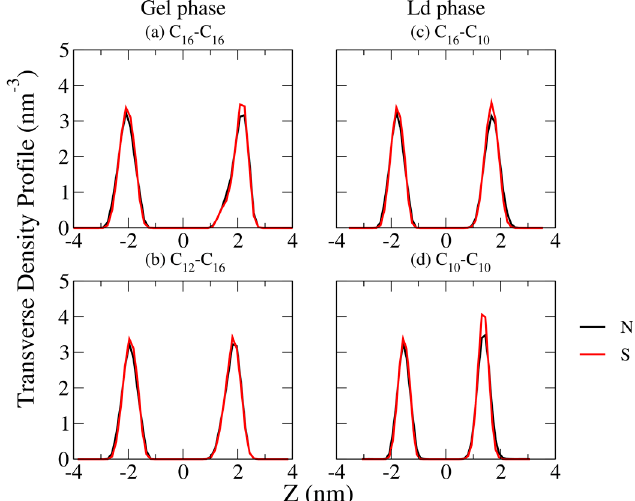
Figure 3. Representative transverse density profiles of nitrogen and sulfur of the charged head groups for the IPA systems of ( a ) C 16 TMA + -C 16 S − and ( b ) C 12 TMA + -C 16 S − in gel (S) phase, and ( c ) C 16 TMA + -C 10 S − and ( d ) C 10 TMA + -C 10 S − systems in liquid-disordered (Ld) phase.